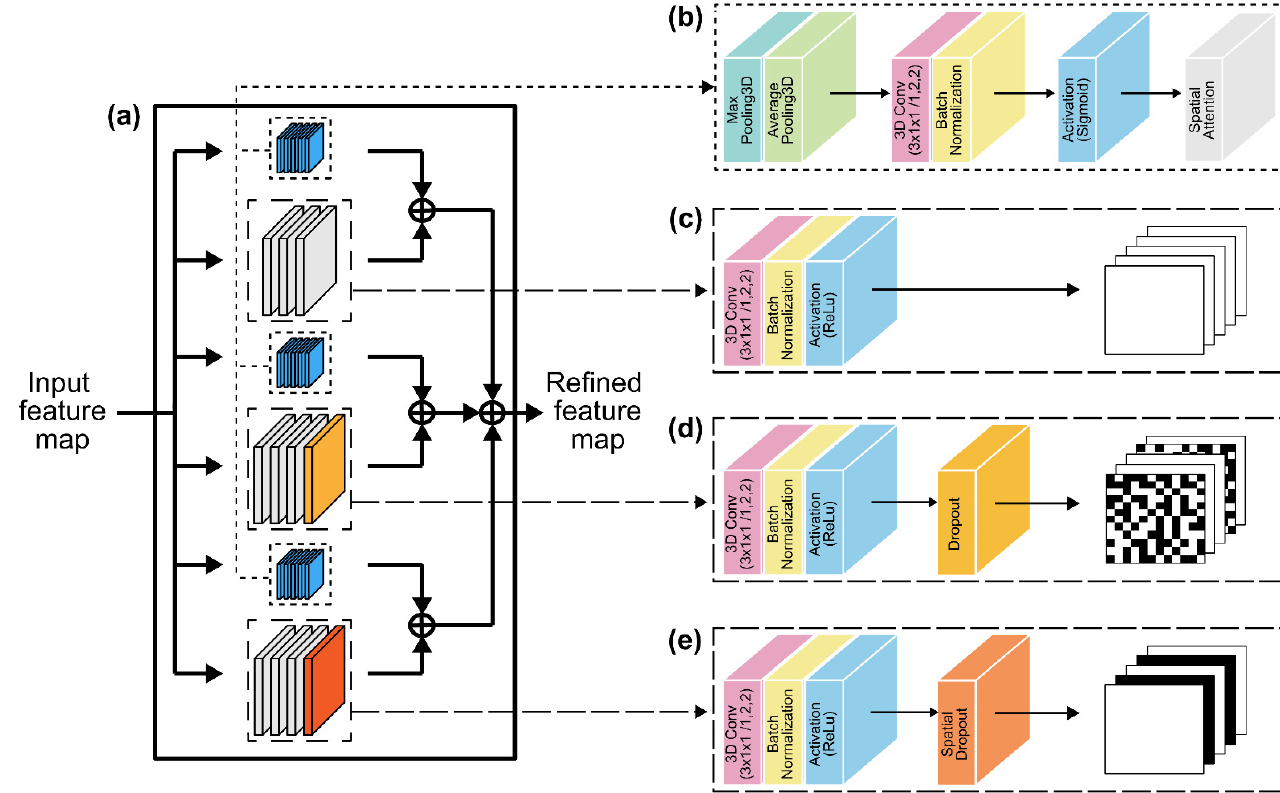
Figure 3. Details of the spatial attention module-integrated MLFF 3D CNN: ( a ) Block diagram of the proposed module; ( b ) spatial attention module; ( c ) first module’s architecture; ( d ) second module’s architecture with dropout layer; and ( e ) third module’s architecture with spatial dropout layer.